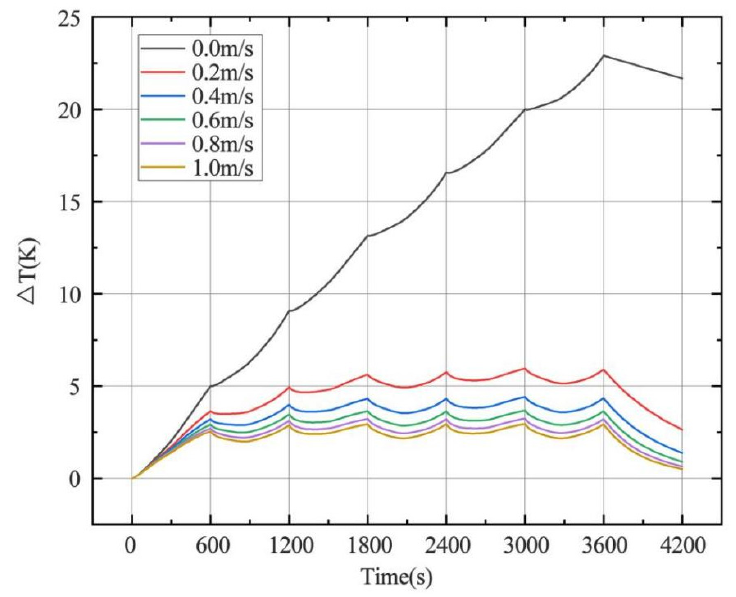
Figure 12. Average temperature changes of batteries at different inlet airflow velocity.